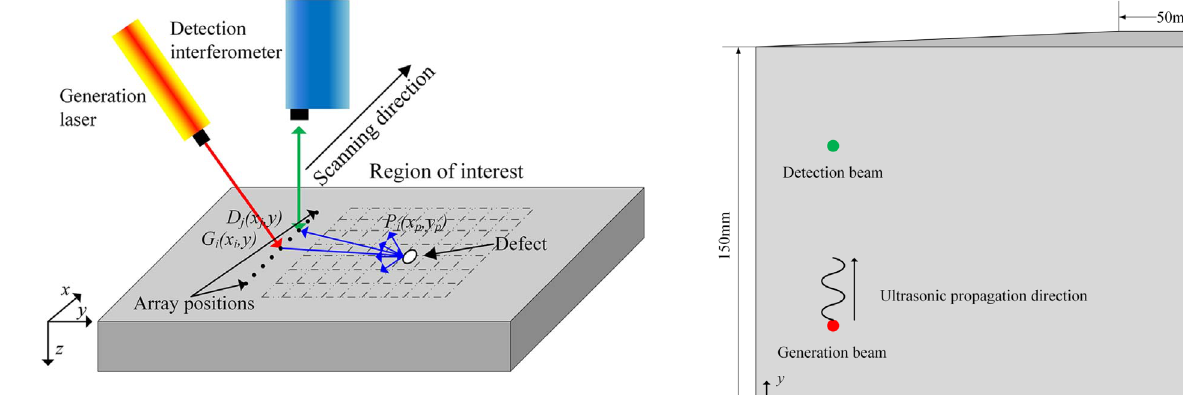
Figure 3. Schematic diagram of laser-induced ultrasonic for FMC data acquisition. The ultrasonic signals are generated by a pulsed laser and the interferometer scans across all positions parallel to the x -axis. Then, the pulse laser is moved to the next position while the interferometer is used to scan repeatedly.